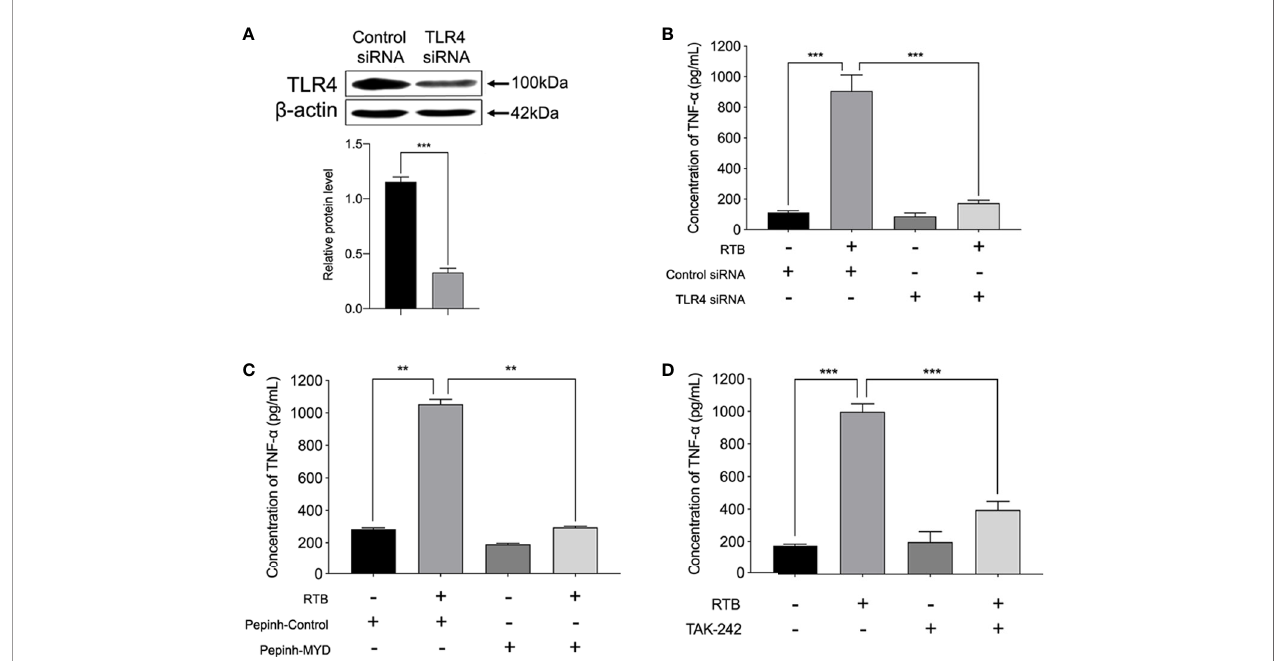
FIGURE 4 | TNF- a production in Raw264.7 cells treated with RTB. (A) Cells were stably transfected with control siRNA or siRNA speci fi c for TLR4.Western blotting analysis of TLR4 in cell lysates. (B) TNF- a production in stably-transfected RAW264.7 cells treated with RTB. TLR4 siRNA stably-transfected RAW264.7 cells were treated with RTB (50 m g/mL) for 24 h. TNF- a production was measured by ELISA. Data are presented as mean ± SD of three replicates. Shown are representative results from one of three experiments with similar results. (C) Raw264.7 cells were treated with or without the MyD88 inhibitor Pepinh-MYD (25 mM) and incubated for 24 h and then stimulated with RTB (50 m g/mL) for 24 h. TNF- a production was measured by ELISA. Data are presented as mean ± SD of three replicates. Representative results from one of three experiments with similar results are shown. (D) Raw264.7 cells were treated with or without another MyD88 inhibitor TAK- 242 (50 nM) and incubated for 24 h and then stimulated with RTB (50 m g/mL) for 24 h. TNF- a production was measured by ELISA. Data are presented as mean ± SD of three replicates. Representative results from one of three experiments with similar results are shown. Signi fi cance was indicated as follows: **p ≤ 0.01; ***p ≤ 0.001.